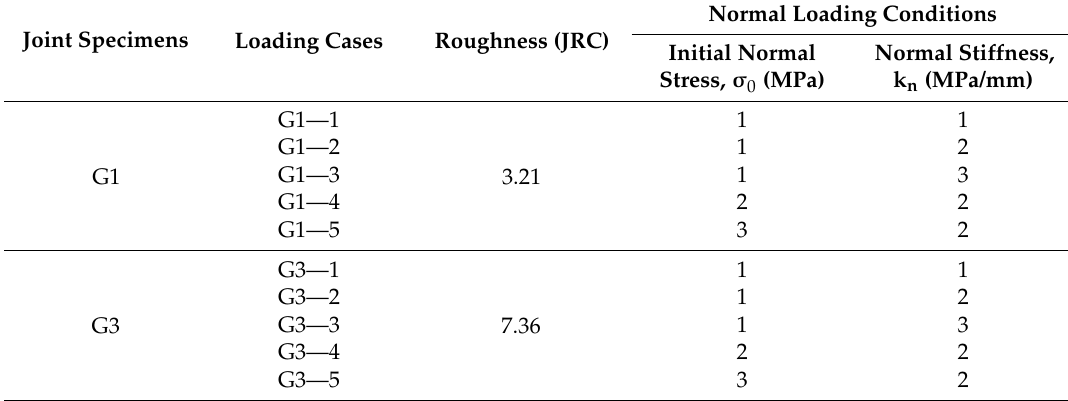
Table 2. Experimental cases and their corresponding boundary